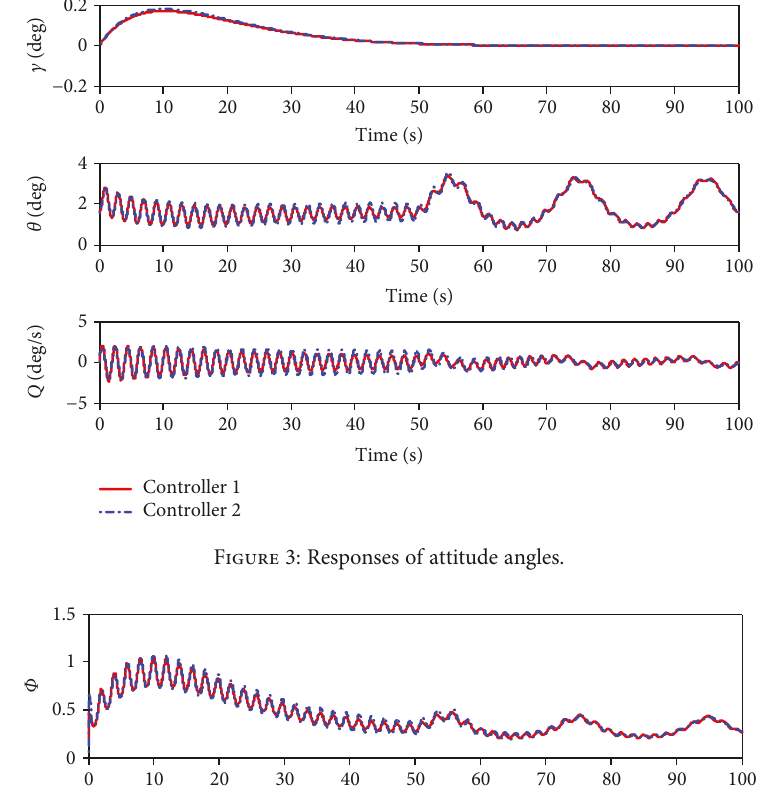
Figure 3: Responses of attitude angles.